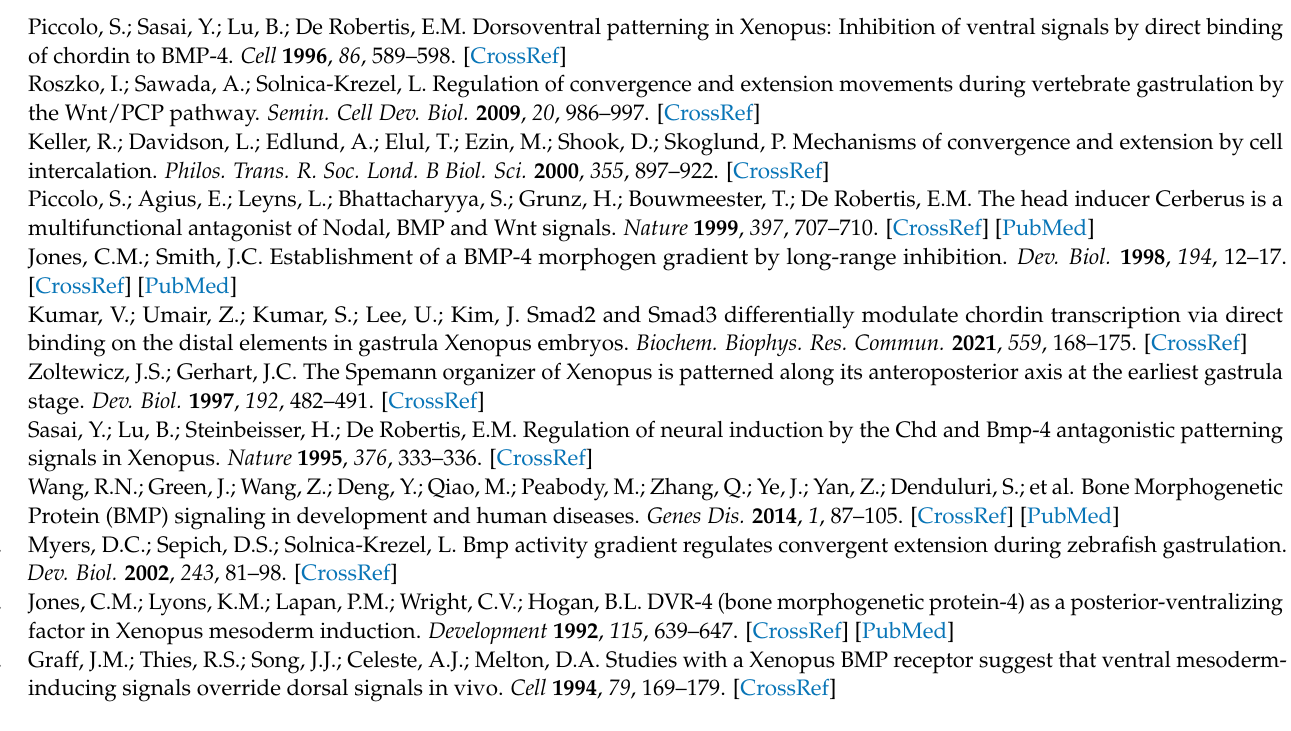
(DN-RhoA) suppressed the secondary axis formation induced by DNBR. Figure S2: Alignment of Xenopus arhgef3.2 sequences with human, chick, lizard, zebrafish and mouse ARHGEF3 sequences. Figure S3: Truncated nuclear localization signal (NLS) block Arhgef3.2 nuclear localization. Figure S4: Arhgef3 is co-localized with Dsh and Daam-1. Table S1: Normalized and analyzed microarray data of upregulated genes from activin treatment. Table S2: Normalized and analyzed microarray data of upregulated genes from Dnbr treatment. Table S3: Normalized and analyzed microarray data of upregulated genes from Fgf